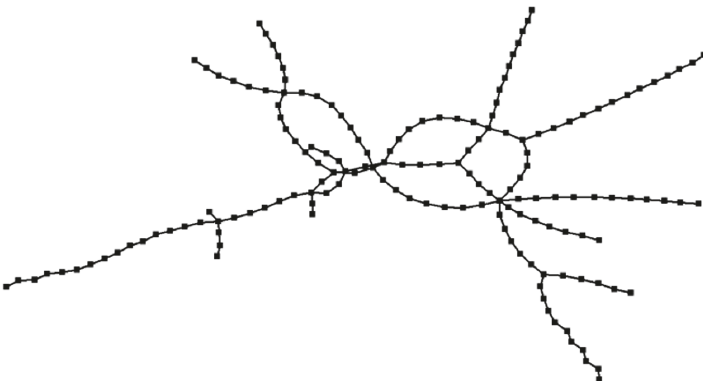
Figure 1: Space L spatial model of Nanjing metro complex network.